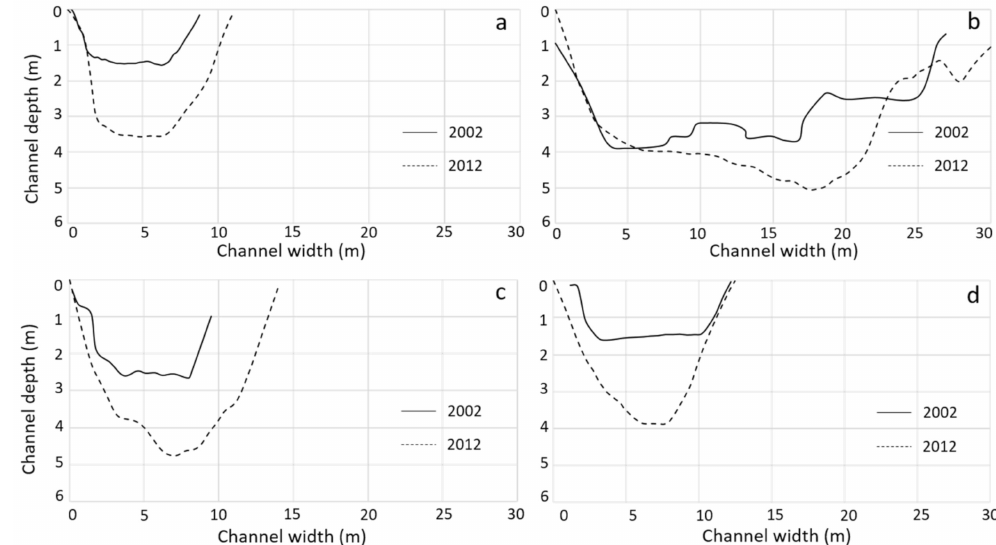
Figure 7. Cross-section profiles at ( a ) 150 m; ( b ) 240 m; ( c ) 425 m; and ( d ) 600 m downstream of the stormwater outfall pipe. The solid line represents the 2002 transects of Julian and Torres (2006). The dashed line shows the cross-section profiles extracted from the 2012 lidar DEM. The comparison of the 2002 and 2012 profiles reveals deepening and widening of the channel over the 10-year interval.